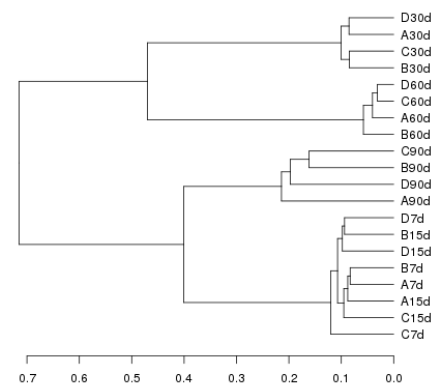
Figure 4. An unweighted, pair-group method with arithmetic means (UPGMA) clustering analysis chart, based on a weighted UniFrac distance matrix. Soil samples are clustered according to their similarity: the shorter the branch length between two samples, the greater their similarity. (A: 0 mg kg −1 ; B: 10 mg kg −1 ; C: 100 mg kg −1 ; D: 1000 mg kg −1 ; 7, 15, 30, 60, and 90 d mean 7, 15, 30, 60, and 90 days, respectively).